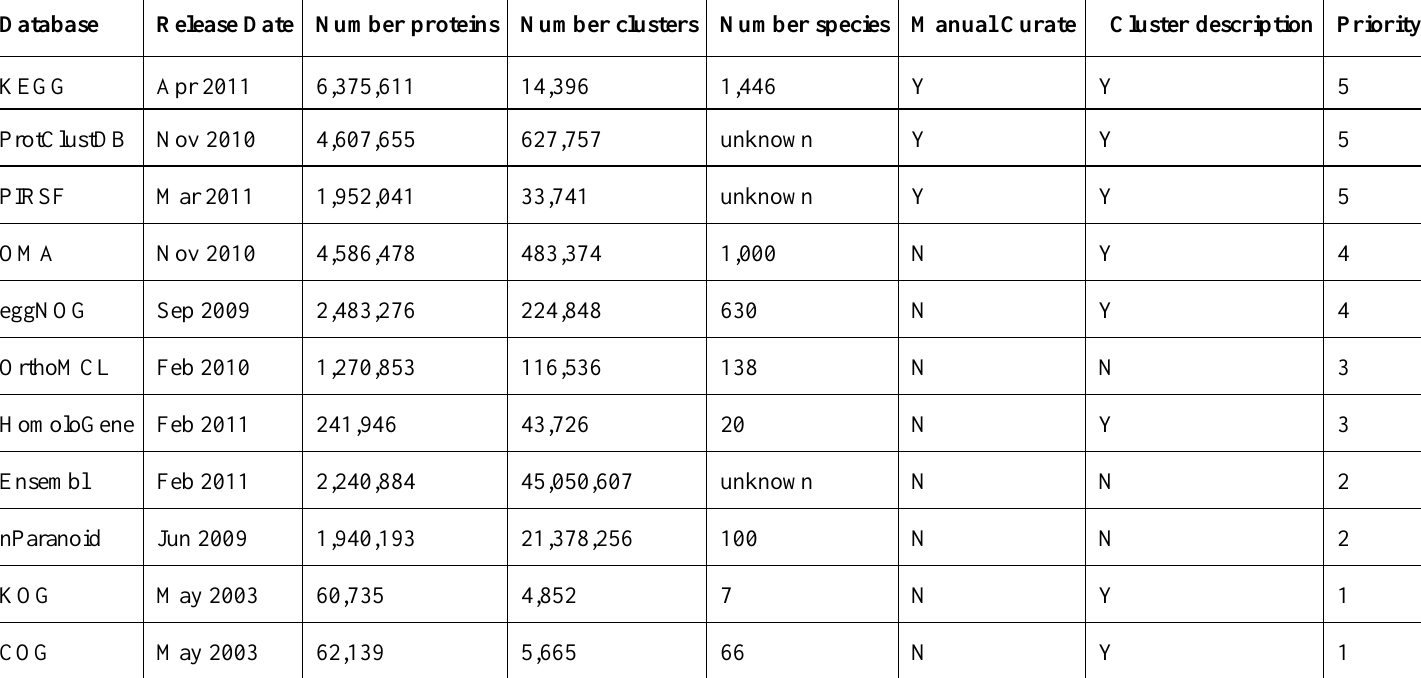
Table S1: Some statistics of 11 orthologous group databases used in the pipeline as part of ProGMap database. Priority scores assign ed to each database are determined by their curate manner, number of protein sequences used and the frequency of database release. Ensembl and InPara noid database get relatively low priority due to their pairwise comparison implementation which may reduce the reliability for some conserved function group